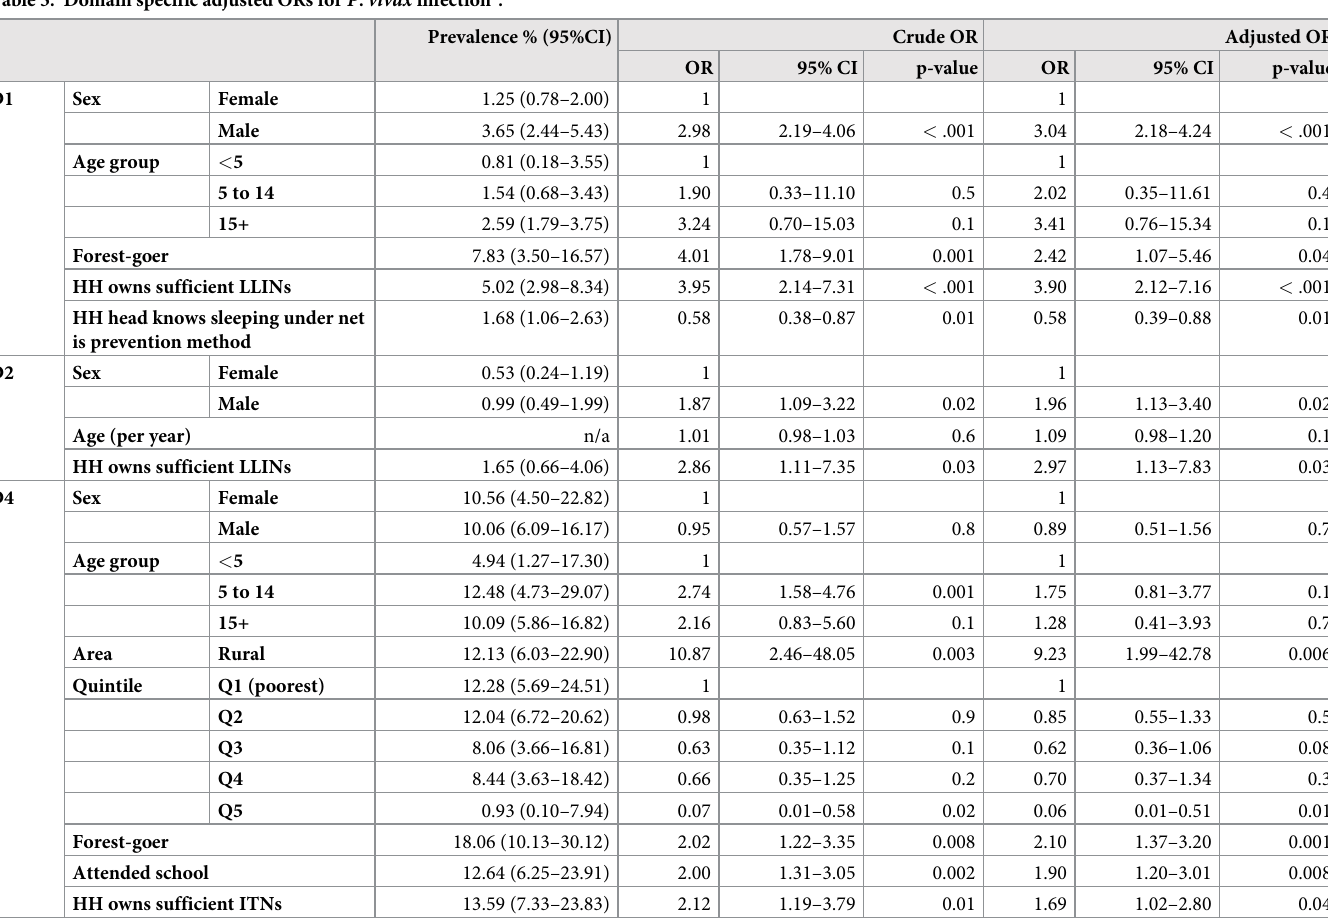
Table 3. Domain specific adjusted ORs for P . vivax infection 1